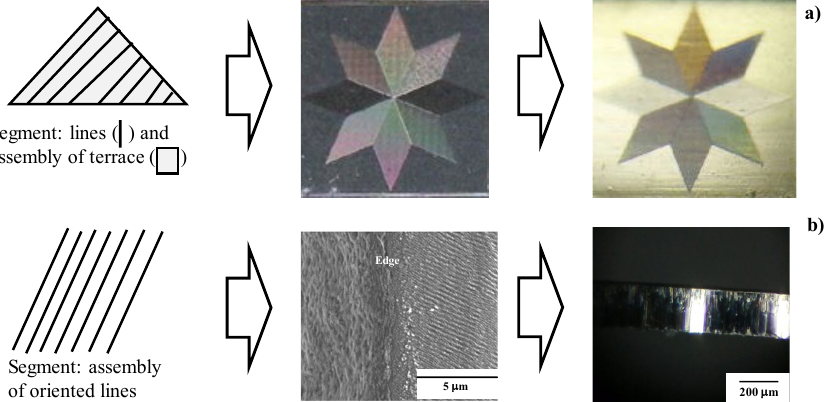
Figure 1. Two data transformation procedures from the design base to the final product by imprinting mother die textures. ( a ) Micro-/nano-patterns → Laser-printed die → Micro-/nano-textured product, and ( b ) nano-patterns → Laser-machined die → Highly qualified product